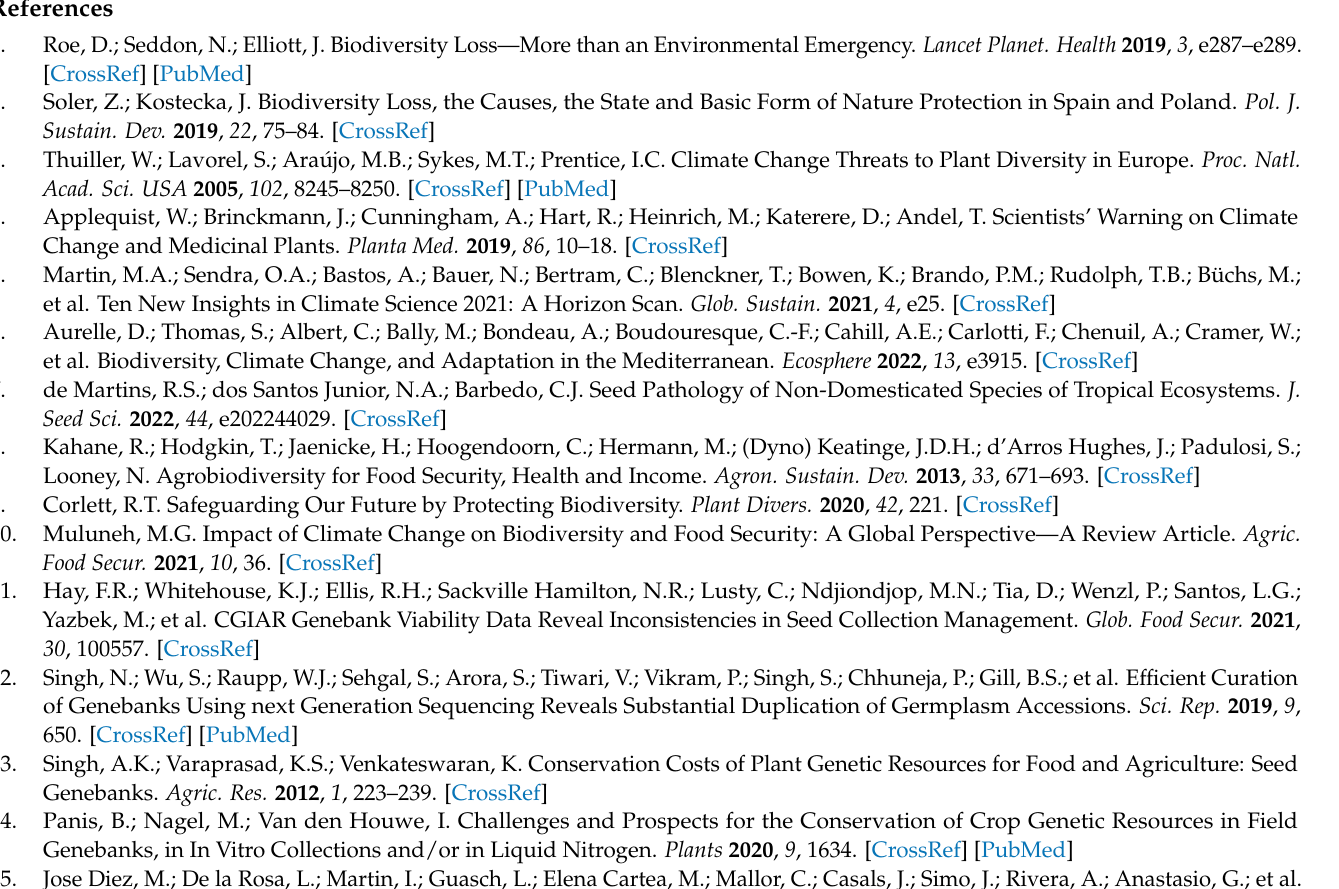
Table S2: The seed accessions of forest trees and shrubs cryopreserved at the Kostrzyca Forest Gene